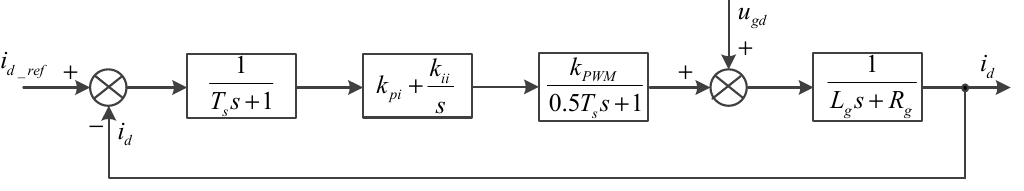
Figure 3. d -axis current loop Figure 3. d-axis current loop structure.